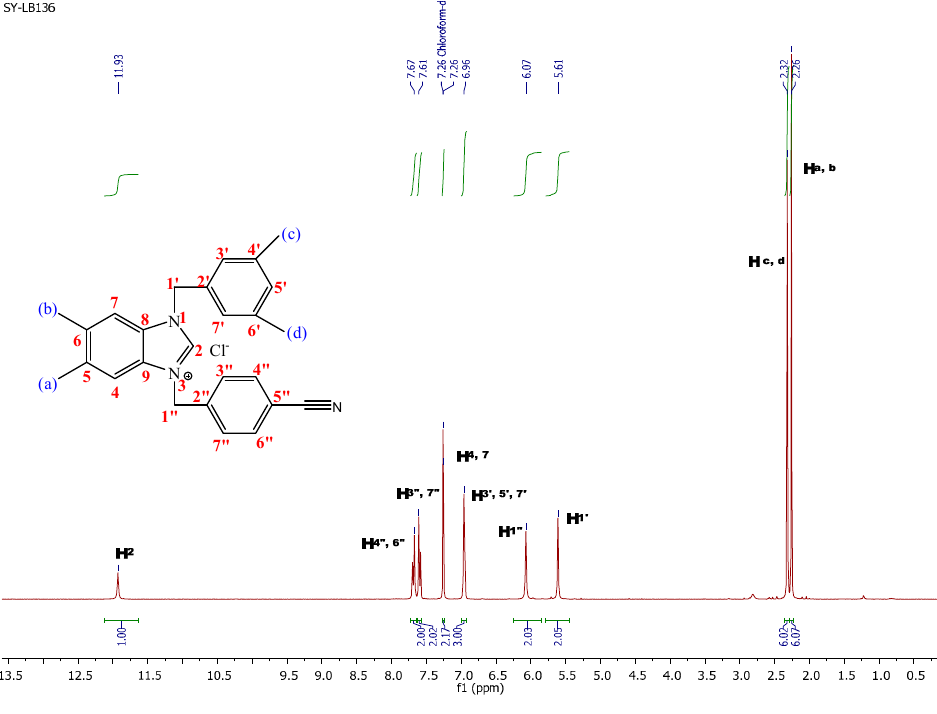
Figure 1. 1 H-NMR spectra of benzimidazolium salt 1b in CDCl 3 .